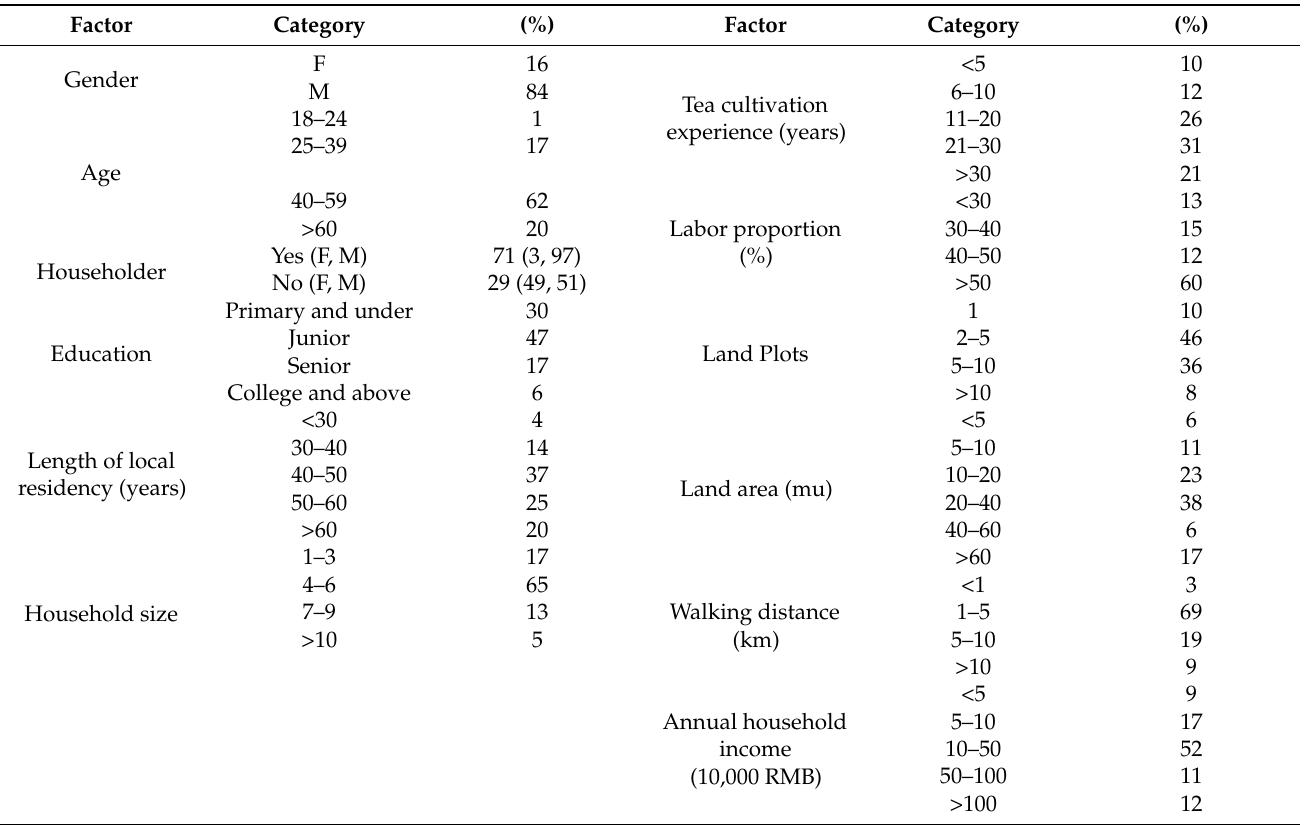
Table 1. Description of the tea farmers involved in the social